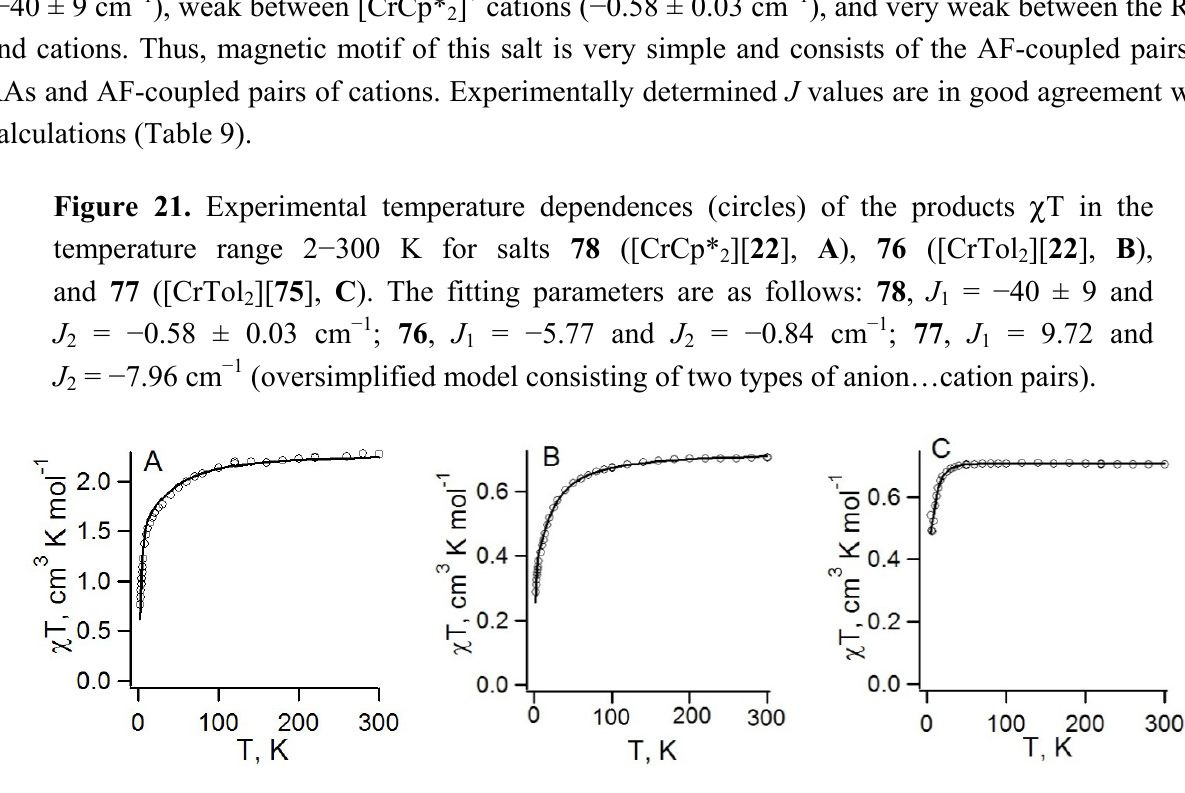
][ 22 ], A ), 76 ([CrTol ][ 22 ], B ), 2 2 = − 40 ± 9 and 1